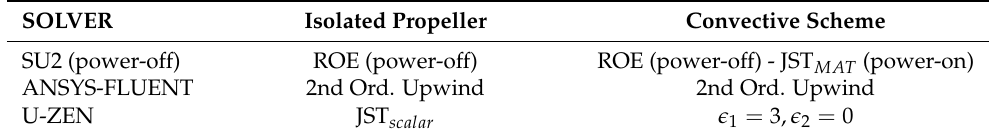
Table 1. Discretization of convective fluxes.